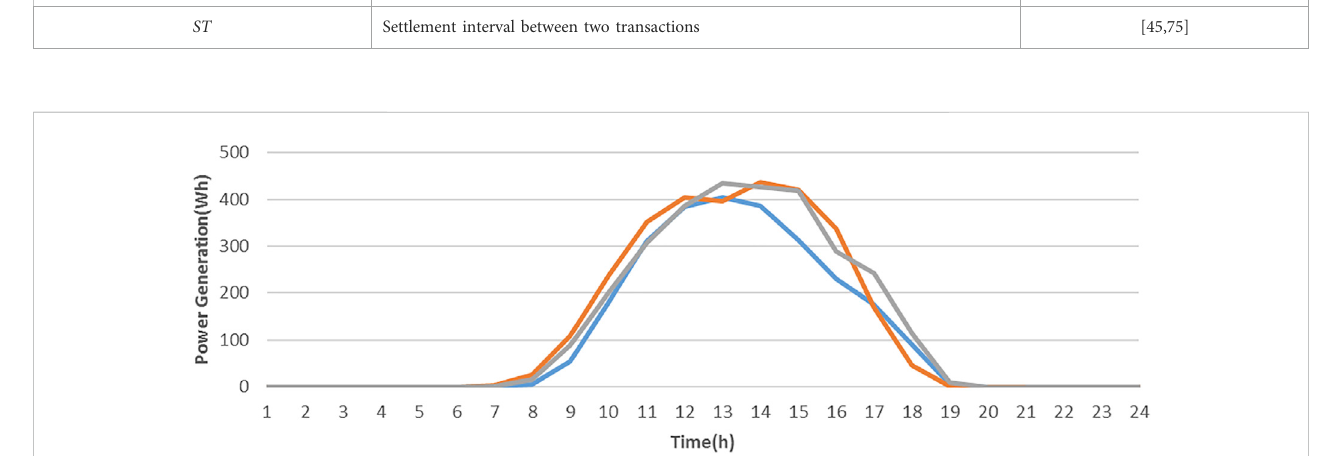
FIGURE 3 Power generation types.